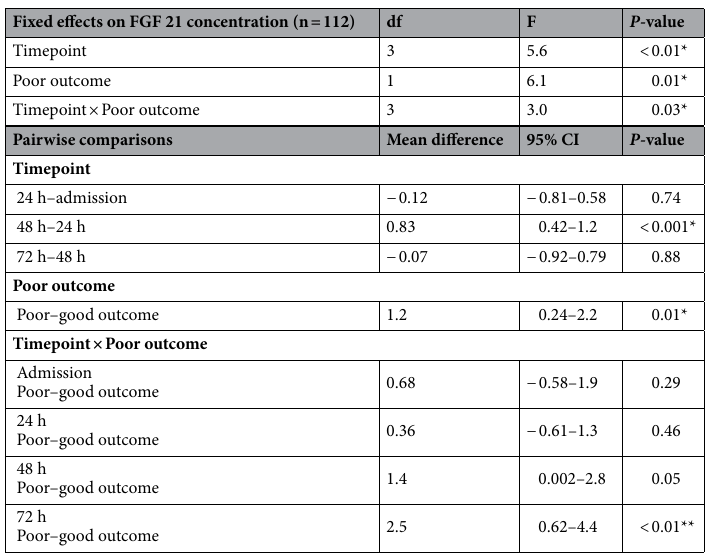
Table 3. Effect of timepoint and outcome. Good outcome, 6-month Cerebral Performance Categories (CPC) 1–2; Poor outcome, 6-month CPC 3–5; df, numerator degrees of freedom; CI, confidence interval. *Statistically significant at the P < 0.05 level (Fixed effects and interactions). **Statistically significant at the P < 0.0125 level (four pairwise comparisons of interactions).